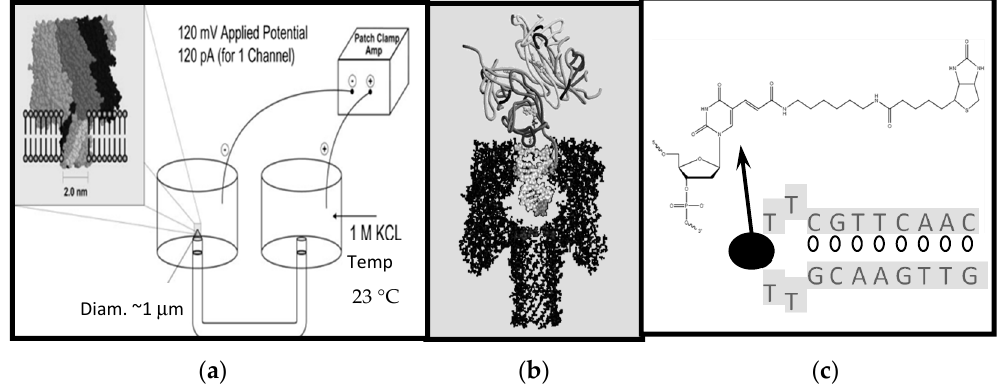
Figure 1. Schematic diagram of the Nanopore Transduction Detector [20]. ( a ) The nanopore detector consists of a single pore in a lipid bilayer which is created by the oligomerization of the staphylococcal alpha-hemolysin toxin in the left chamber, and a patch clamp amplifier capable of measuring pico Ampere channel currents located in the upper right-hand corner; ( b ) A biotinylated DNA hairpin molecule captured in the channel’s cis -vestibule, with streptavidin bound to the biotin linkage that is attached to the loop of the DNA hairpin; ( c ) The biotinylated DNA hairpin molecule (Bt-8gc) of ( b ).